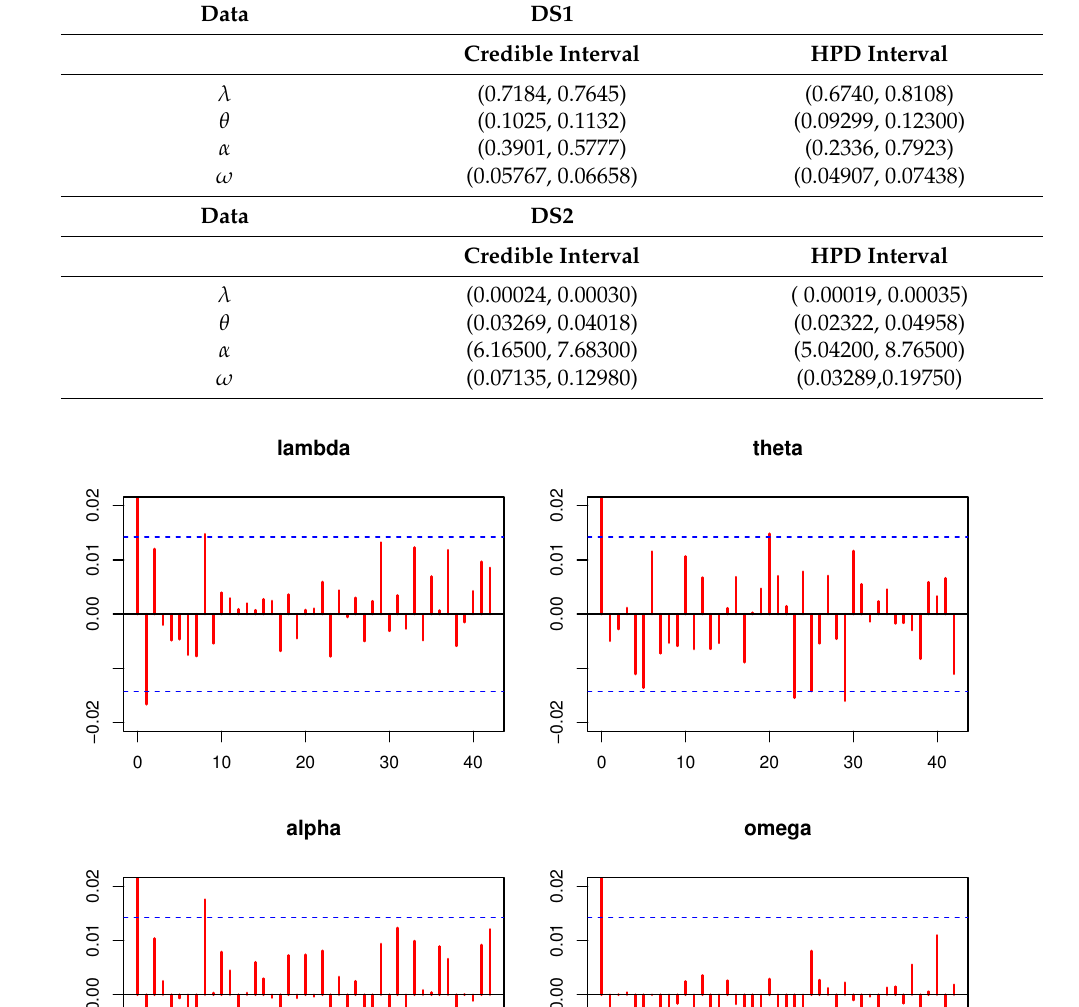
Table 5. Credible and HPD intervals of parameters λ , θ , α and ω for DS1 and DS2 datasets.